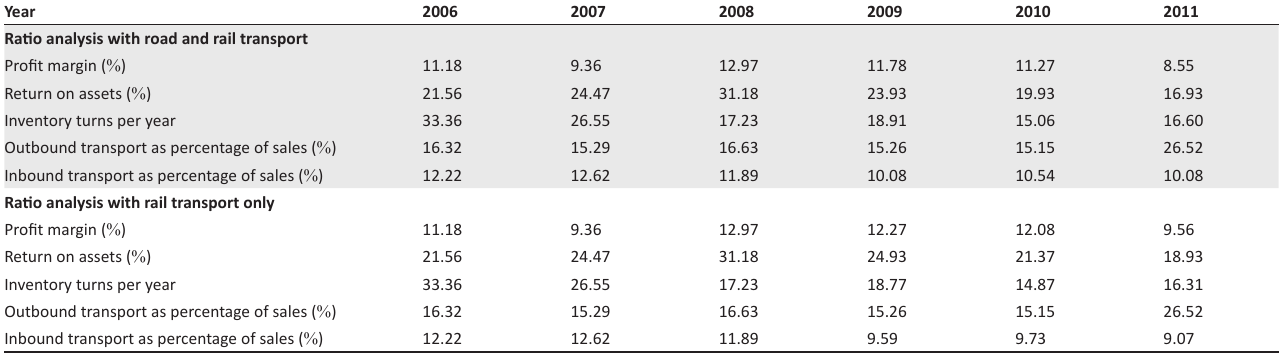
TABLE 4: Ratio analysis with road and rail transport versus only rail